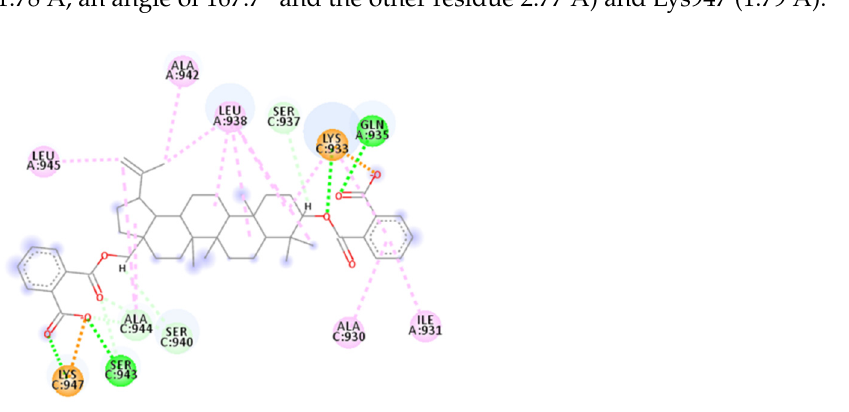
Figure 15. Calculated 2D interactions of SN00114935 in complex with SARS-CoV-2’s HR1 domain. The central portion with five fused rings mainly occupies the hydrophobic pocket.